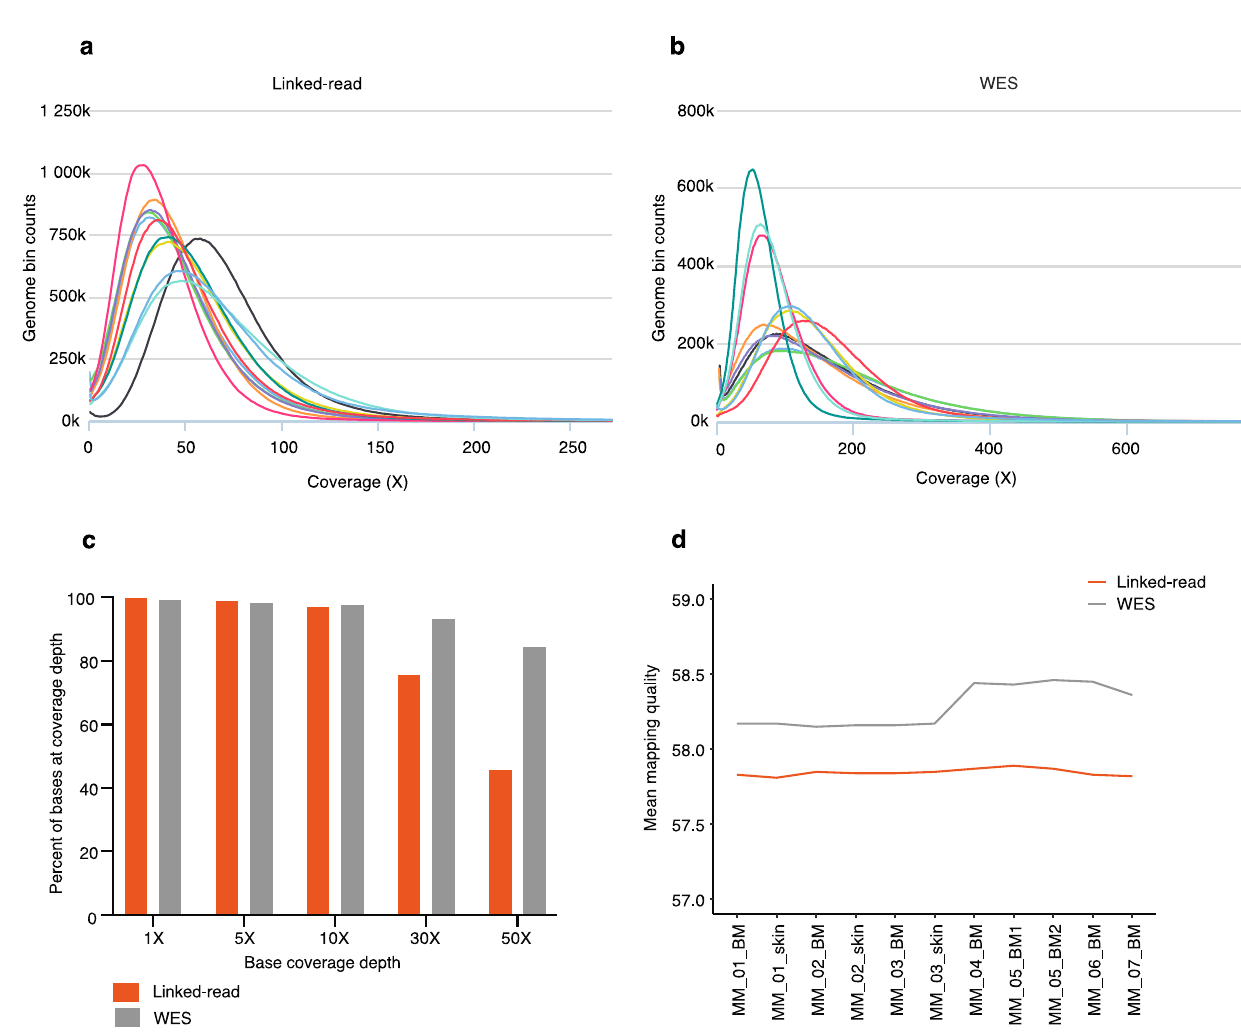
Figure 2. Sequencing and mapping quality statistics across all 8 MM samples and 3 skin samples. The coverage histograms for linked-read ( a ) and WES ( b ) show the number of reference bases plotted against the read depth (depth of coverage). The x -axis represents coverage, and the y -axis represents genome bin counts. Aggregating coverage values conveniently scale the bins of the x -axis. ( c ) The bar plot depicts the fraction of the genome with 1 × , 5 × , 10 × , 30 × , 50 × coverage depths by linked-read and WES sequencing. The x -axis represents base coverage depth, and the y -axis represents the percent of bases at coverage depth. ( d ) The mean mapping quality inside of regions is plotted for each sample sequenced using both linked-read and WES methods.